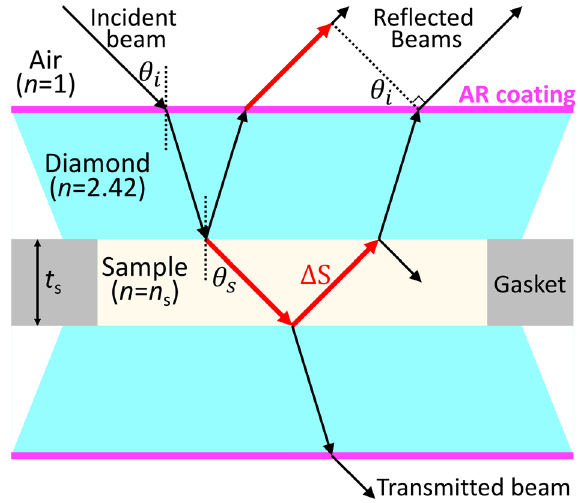
Figure 1. Schematic of the multiple reflections of an incident beam in the sample chamber acting as a Fabry– Perot cavity between the two diamond culet surfaces. Red arrows indicate the optical path difference ( (cid:31) S ) of the first two reflected beams from the